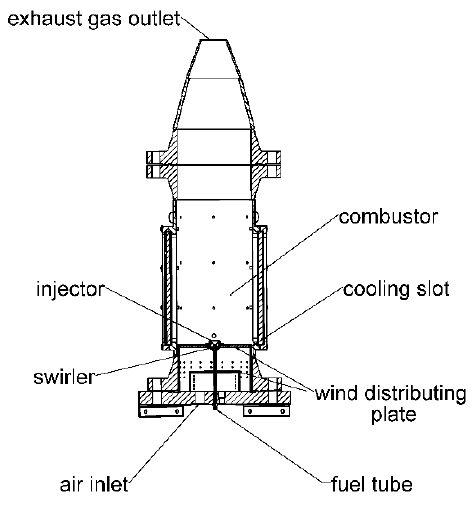
Figure 3. The combustion chamber.